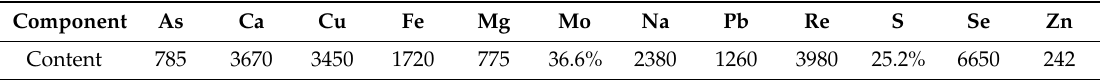
Table 2. Composition of flue dust before leaching